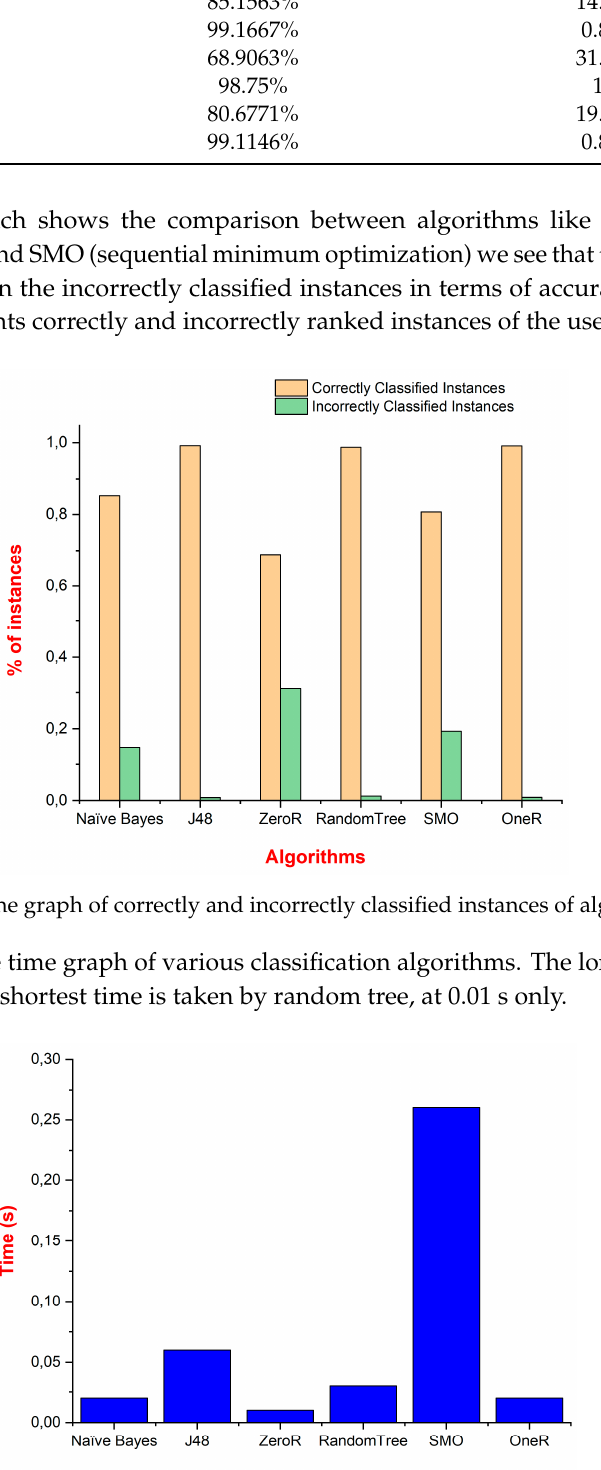
Figure 11. The graph for training time results for different algorithms.